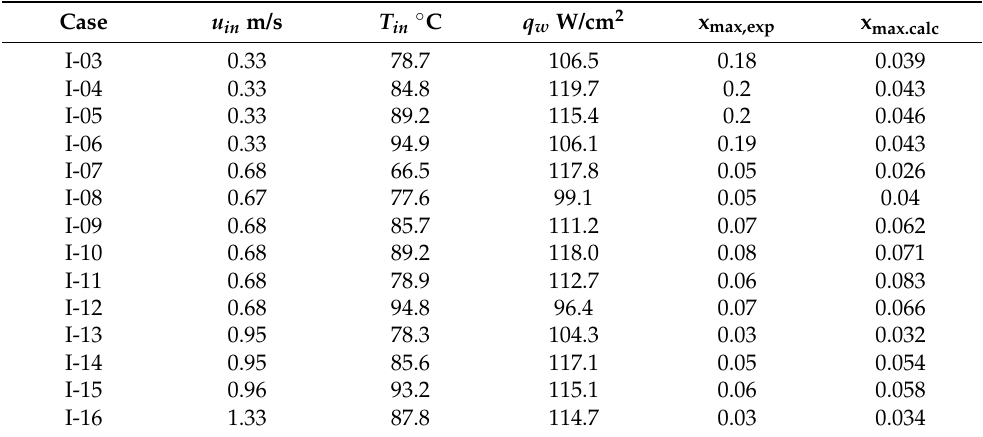
Table 4. A comparison between the predicted vapor quality at the outlet section of the microchannel and the flow boiling experiment [26]. T sat = 100 ◦